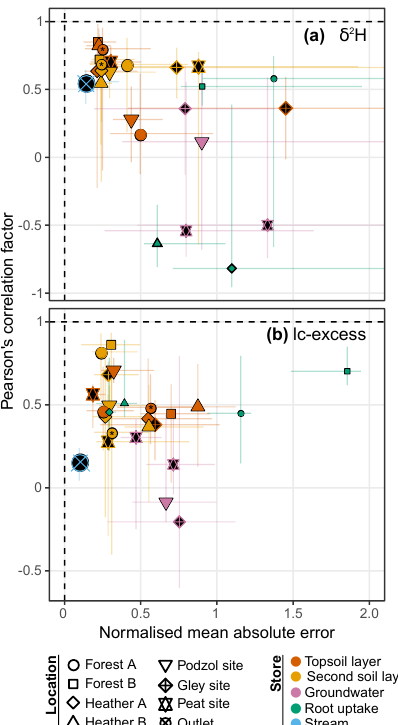
Figure 8. Summary of model performance in the dual space of mean absolute error (normalised by the observed range of values) and Pearson’s correlation factor between modelled and observed time series, for (a) δ 2 H and (b) lc-excess, showing the median and 90% spread over the ensemble. The size of each symbol is proportional to the logarithm of the number of observation points available. Perfor- mance in soil compartments at Forest site A is further separated be- tween the periods 2013 and 2015–2016 (the latter indicated with an asterisk), corresponding to two separate field data collection cam- paigns. Two groundwater wells are presents at the peat